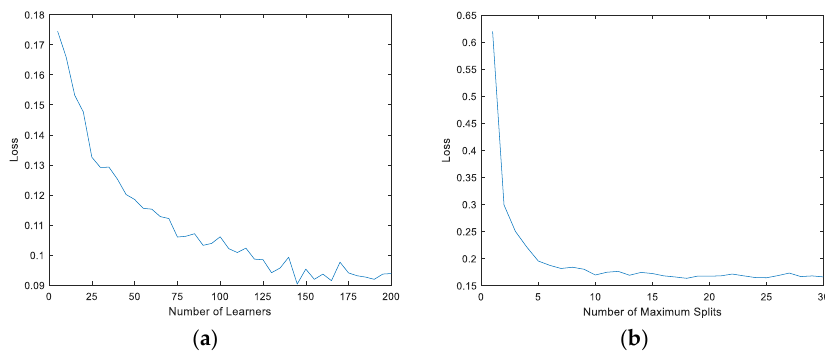
Figure 5. ( a ) Loss varies with the number of weak learners; ( b ) loss varies with the maximum number of splits.